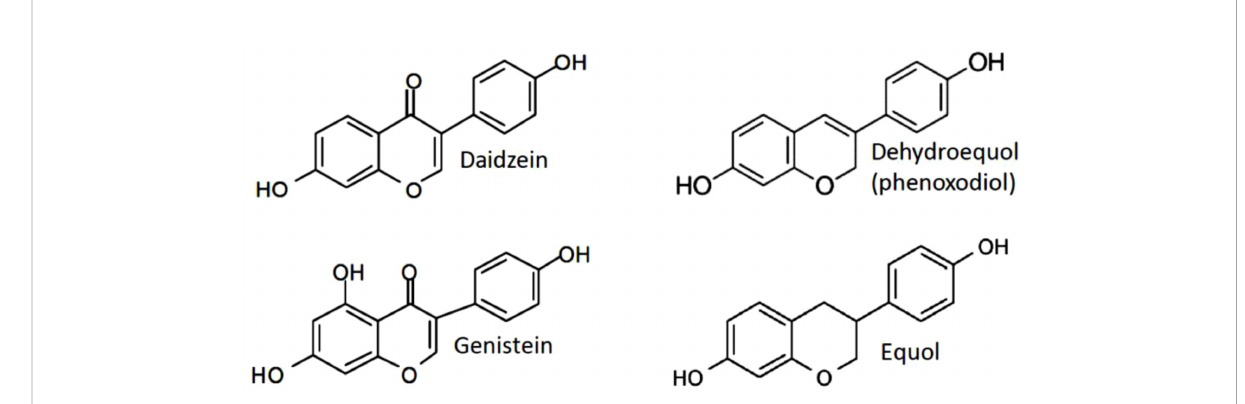
FIGURE 1 Structures of the mainly studied iso fl avones daidzein, genistein, phenoxodiol (idronoxil) and equol compared to estradiol-17 b